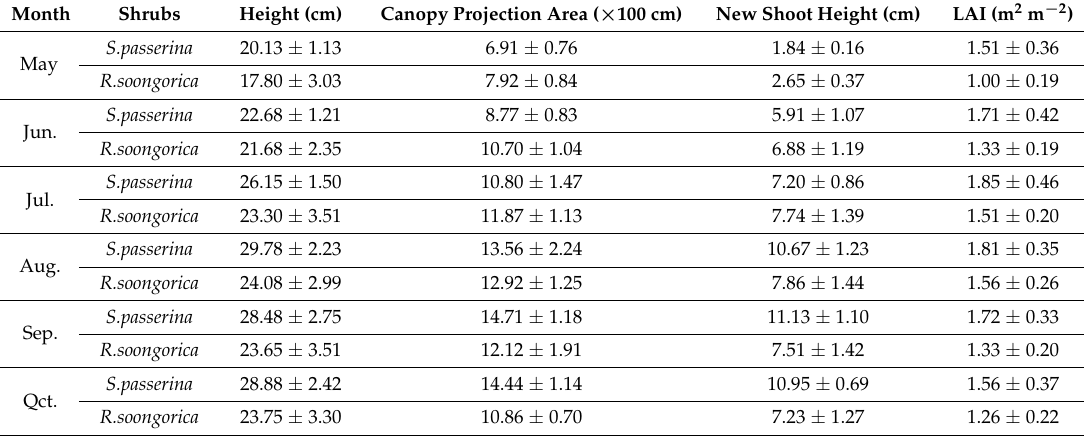
Table 1. The values (means ± standard errors) of the canopy height, canopy projection area, new shoot length, and leaf area index (LAI) of R. soongorica and S. passerine